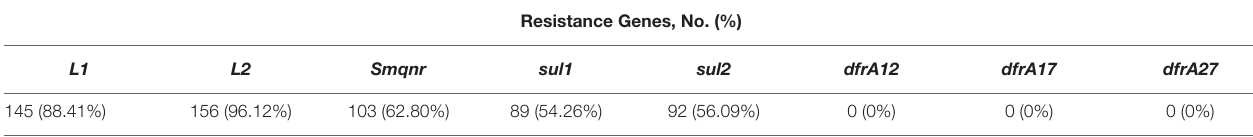
TABLE 4 | Sequence type (ST) of TMP-SMX-resistant S. maltophilia clinical isolates recovered in the present study. Number of